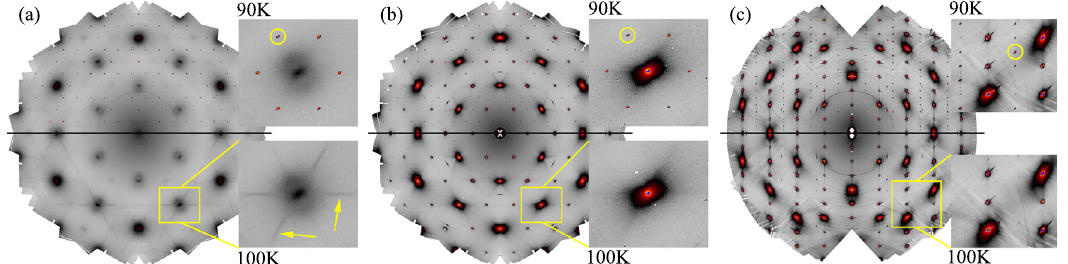
Fig.2|DiffusescatteringmapsofCsV 3 Sb 5 .a ( hk 0.5)planeat90K(top),showing theCDWre fl ections(weakspotshighlightedwithintheyellowcircleinthezoomed in area) and the precursor of the 3D CDW at 100 K (bottom), marked with arrows.